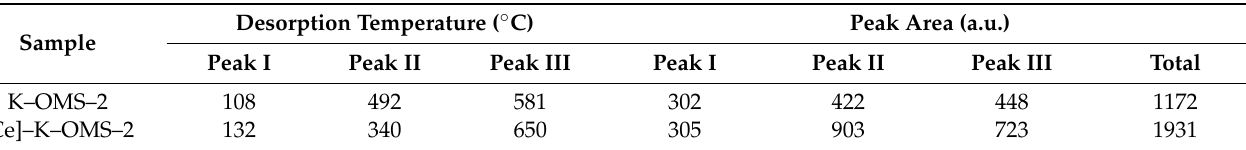
Table 4. Acidic properties of Ce-doped K–OMS–2 ([Ce]–K–OMS–2) and undoped K–OMS–2. Data were extracted and adapted from [156].